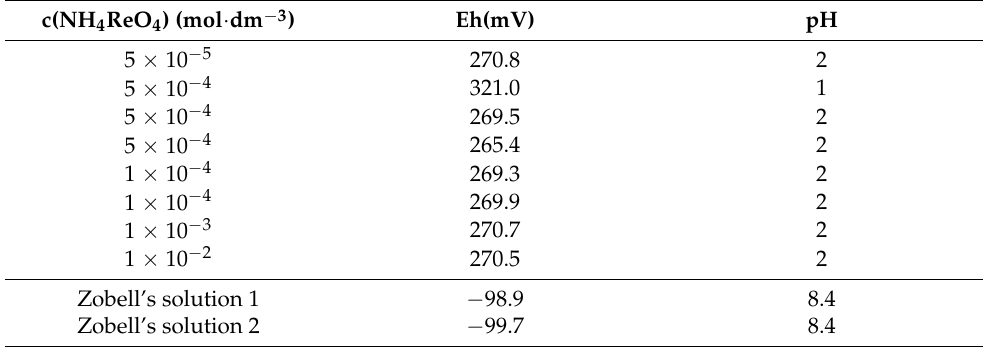
Table 6. Results of Eh(V) and pH measurements in NH 4 ReO 4 solutions labelled with [ 99m Tc]NaTcO 4